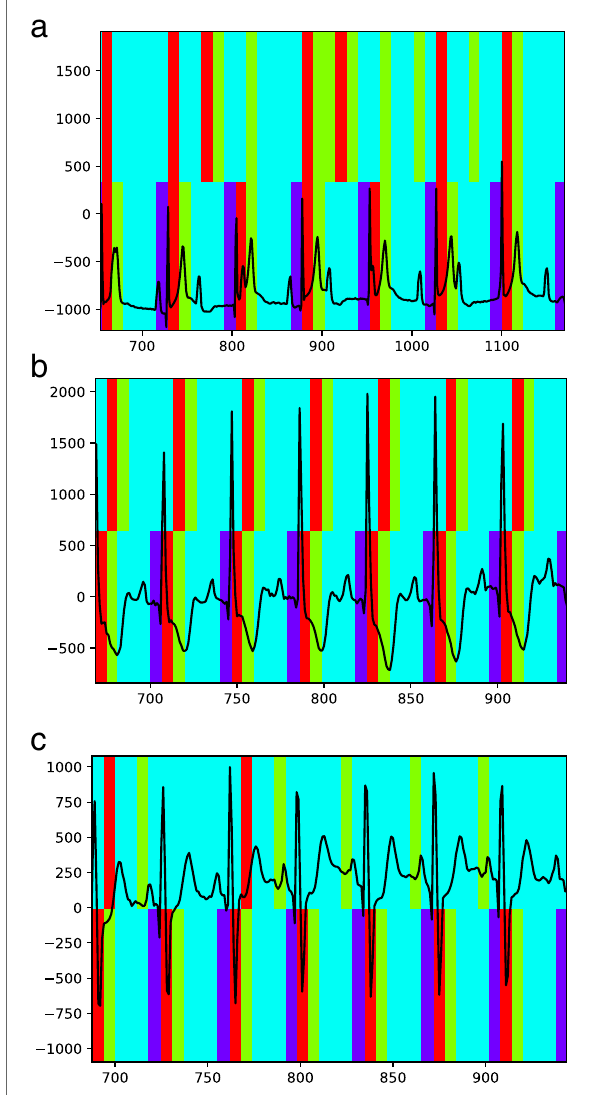
Fig. 4 Classifier applied to ill patients. a Classifier applied to a dysrthythmia patient, b Classifier applied to a valvular-heart-disease patient, c Classifier applied to a myocardial-infarction